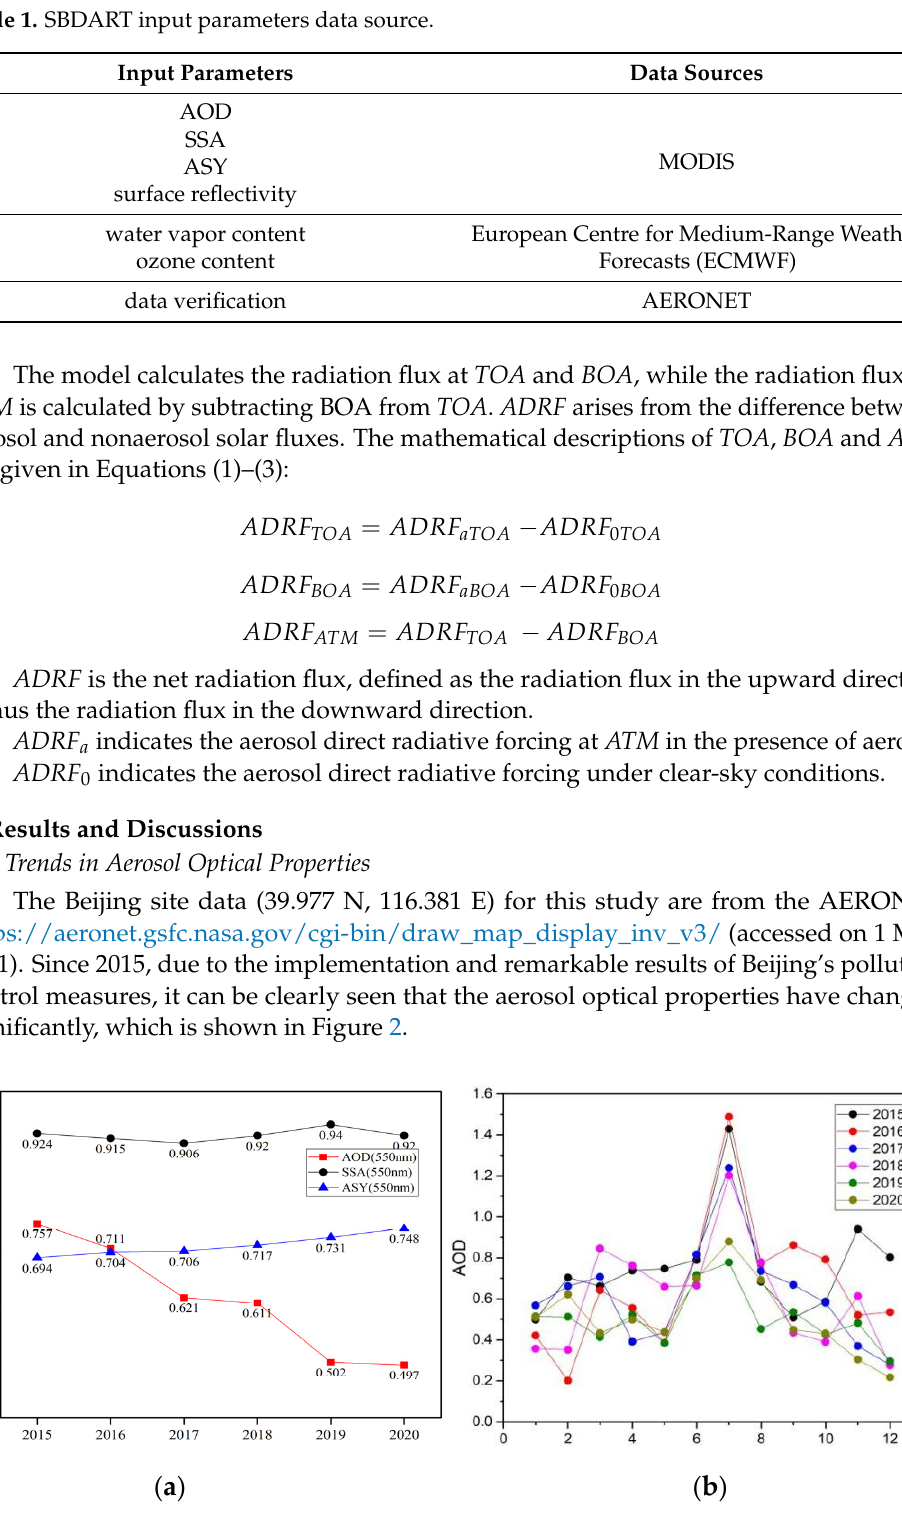
Figure 2. Description of aerosol optical characteristic parameters: ( a ) annual change trend graph of aerosol optical properties; ( b ) monthly change trend graph of AOD from 2015 to 2020.